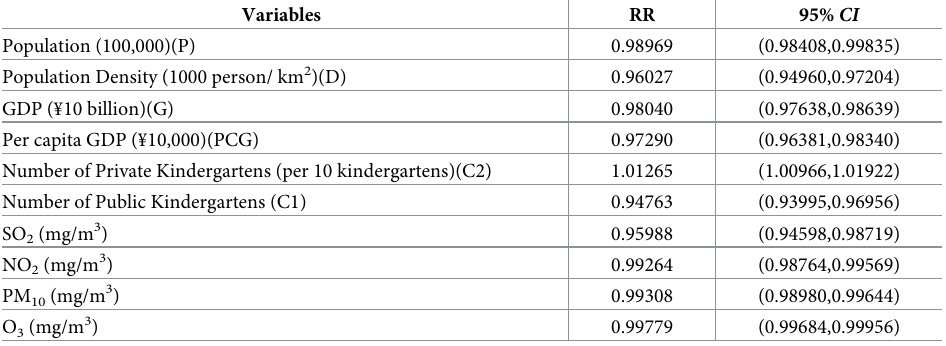
Table 4. The regression coefficients of the univariate Bayesian models with respect to the different factor